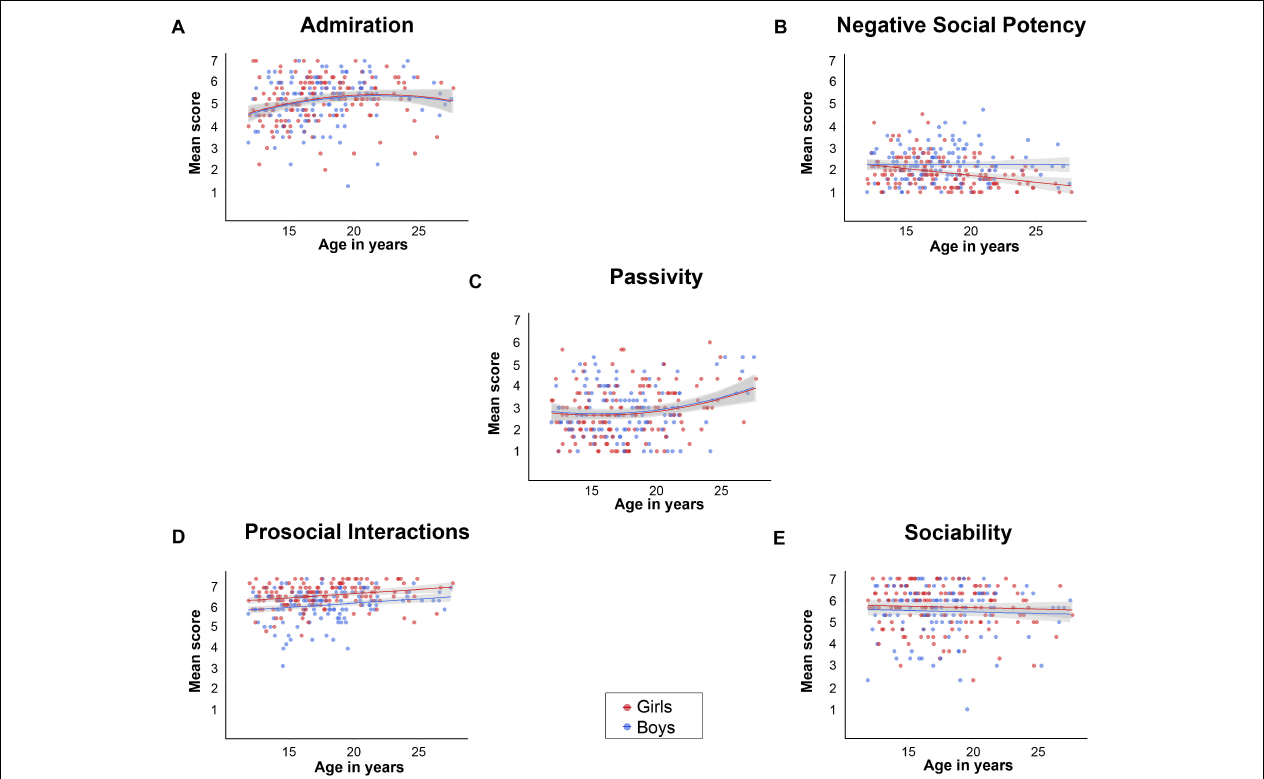
FIGURE 1 | Mean scores on each SRQ-A subscale of adolescents and young adults between ages 11–28 years. (A) Mean scores of Admiration showing a quadratic age effect, with a peak at 21.34 years old. (B) Mean scores of Negative Social Potency showing an interaction effect of gender and age. (C) Mean scores of Passivity showing a quadratic age effect, with a dip at 15.40 years old. (D) Mean scores of Prosocial Interactions showing a main effect for gender and a main effect of age, and (E) mean scores of Sociability showing no main nor interaction